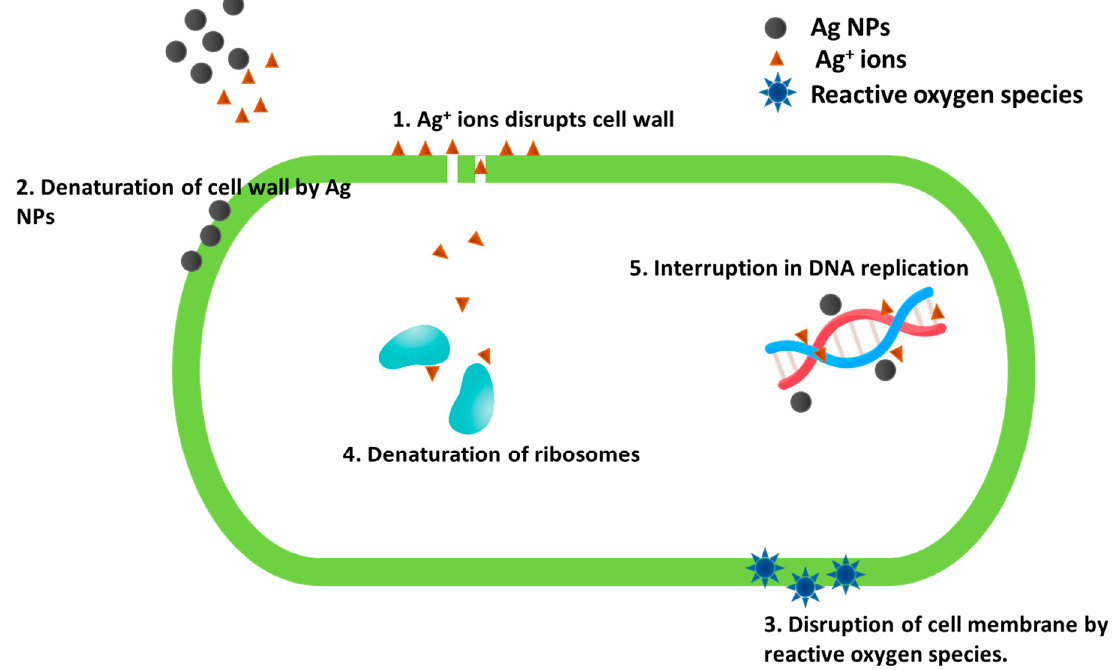
Figure 5. Mechanism of antibacterial action of AgNPs. (1) Ag + ions disrupt cell wall. AgNPs release Ag + ions which adhere to the bacterial cell wall and thereby pass through the cell wall and cytoplasmic membrane. (2) Denaturation of cell wall by AgNPs. AgNPs accumulate on the cell wall and cytoplasmic membrane and cause membrane denaturation. (3) Disruption of cell membrane by reactive oxygen species. The reactive oxygen species produced by AgNPs lead to disruption of cell membrane. (4) Denaturation of ribosomes. Silver ions, after moving into the cell cytoplasm, adhere to the ribosome and thereby hinder the synthesis of proteins. (5) Interruption in DNA replication. The process of DNA replication is hindered when AgNPs bind to various heteroatoms such as nitrogen and sulphur present in DNA.